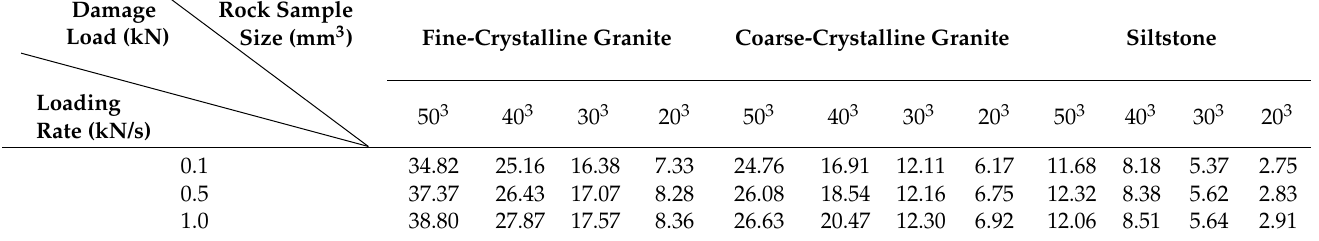
Table 3. Damage load statistics of the three rock samples with different sizes and loading